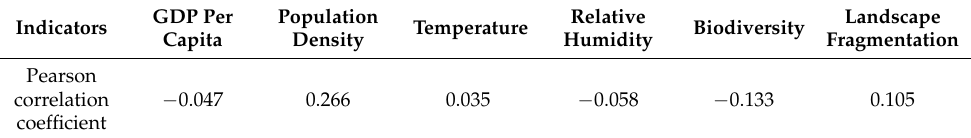
Table 1. The correlation coefficients of different environmental